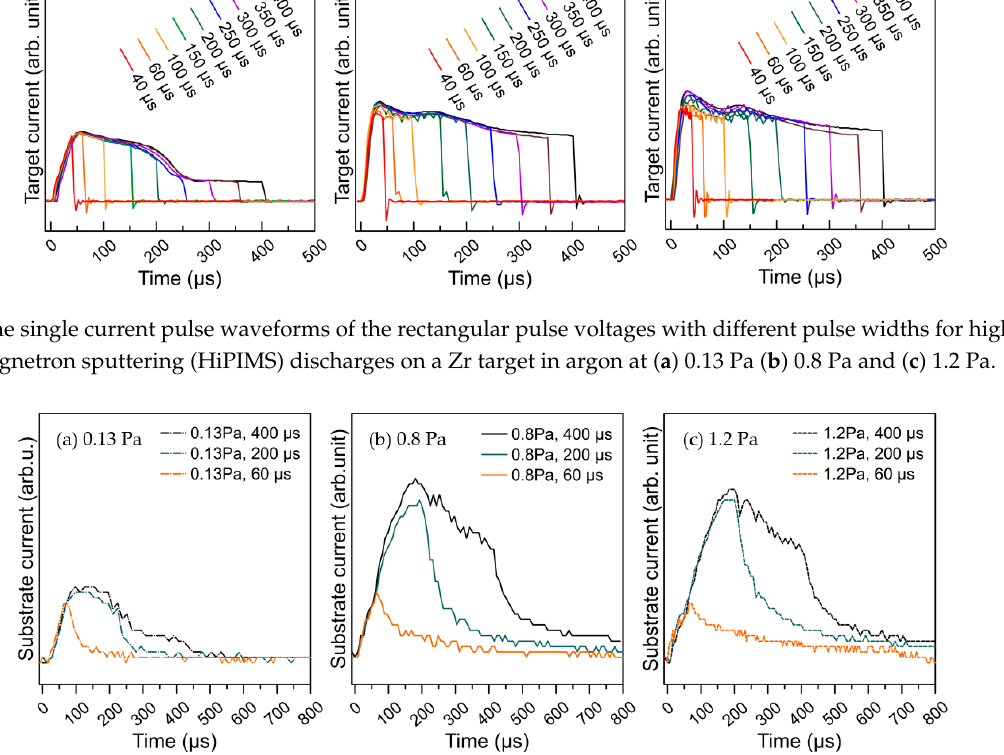
Figure 2. The responded substrate bias current pulse waveforms of a constant substrate bias pulse voltage of − 800 V for 1 ms width, which are synchronized with the HiPIMS discharges pulse widths of the Zr target in argon at ( a ) 0.13 Pa ( b ) 0.8 Pa and ( c ) 1.2 Pa.